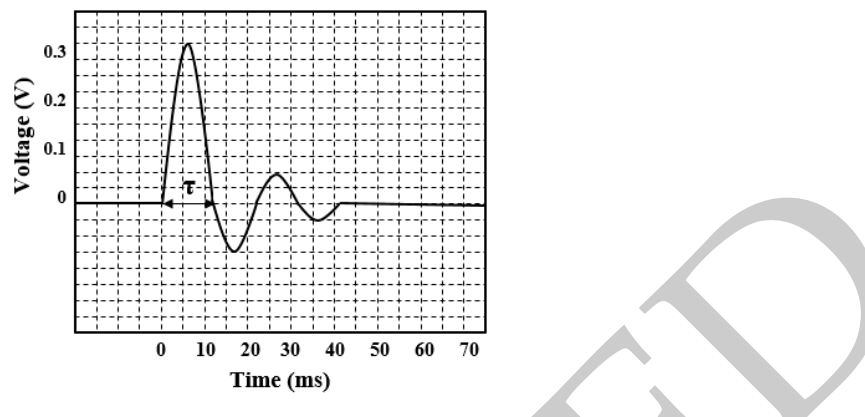
Figure 9. Square-wave time response of the CTA circuit.